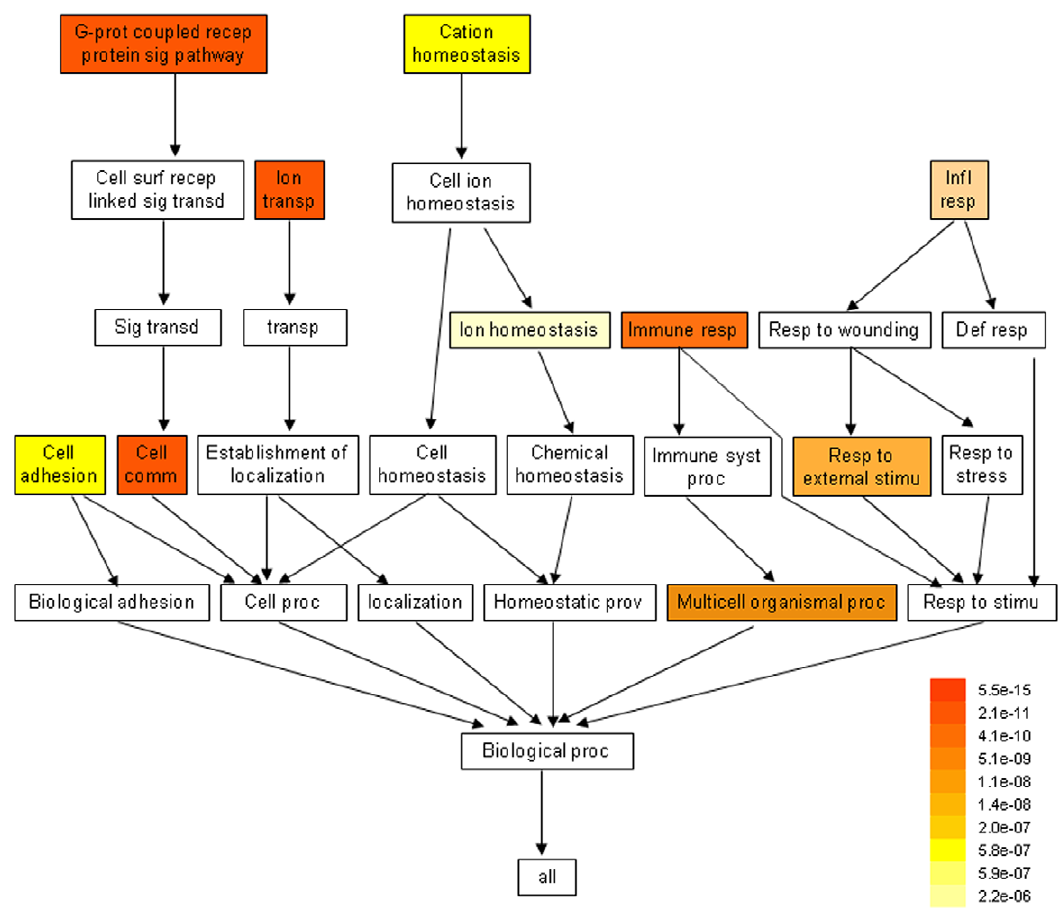
Figure 2. Biological Process Gene Ontology (GO) terms underrepresented in oocytes and embryos when compared with adult tissues. Colors indicate the significance (p-value) of the underrepresentation.